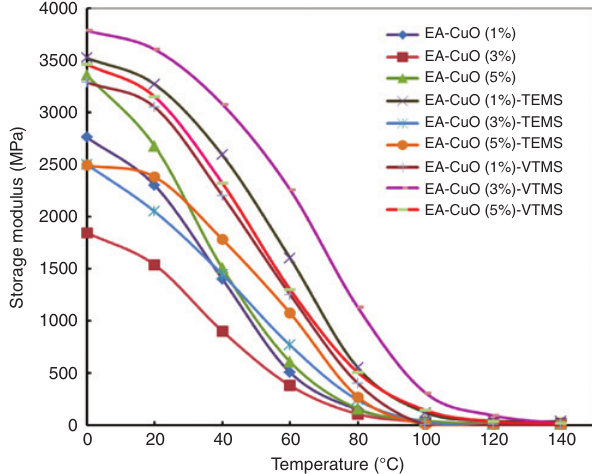
Figure 7: Storage modulus of epoxy-acrylate nanocomposites measured by